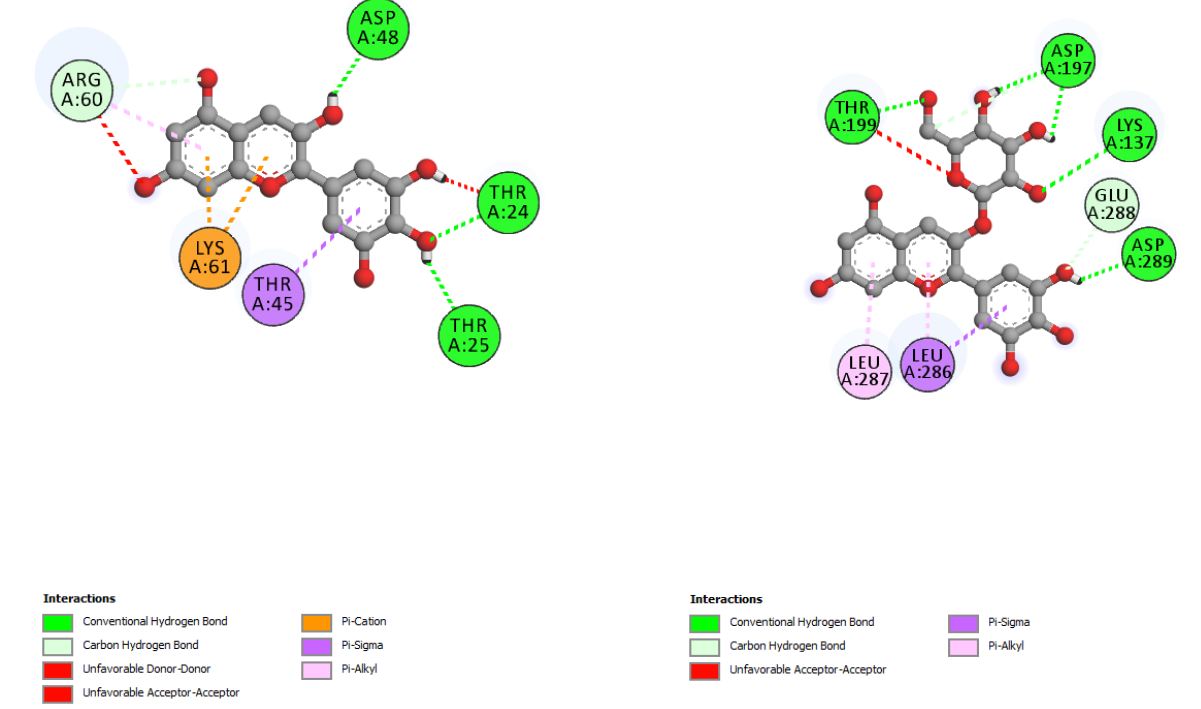
Figure 7 . Interaction of delphinidin ( left ) and delphidin - 3 - glucoside ( right ) with Mpro ( with bound Figure 7. Interaction of delphinidin ( left ) and delphidin-3-glucoside ( right ) with Mpro (with bound inhibitor N3 ). inhibitor